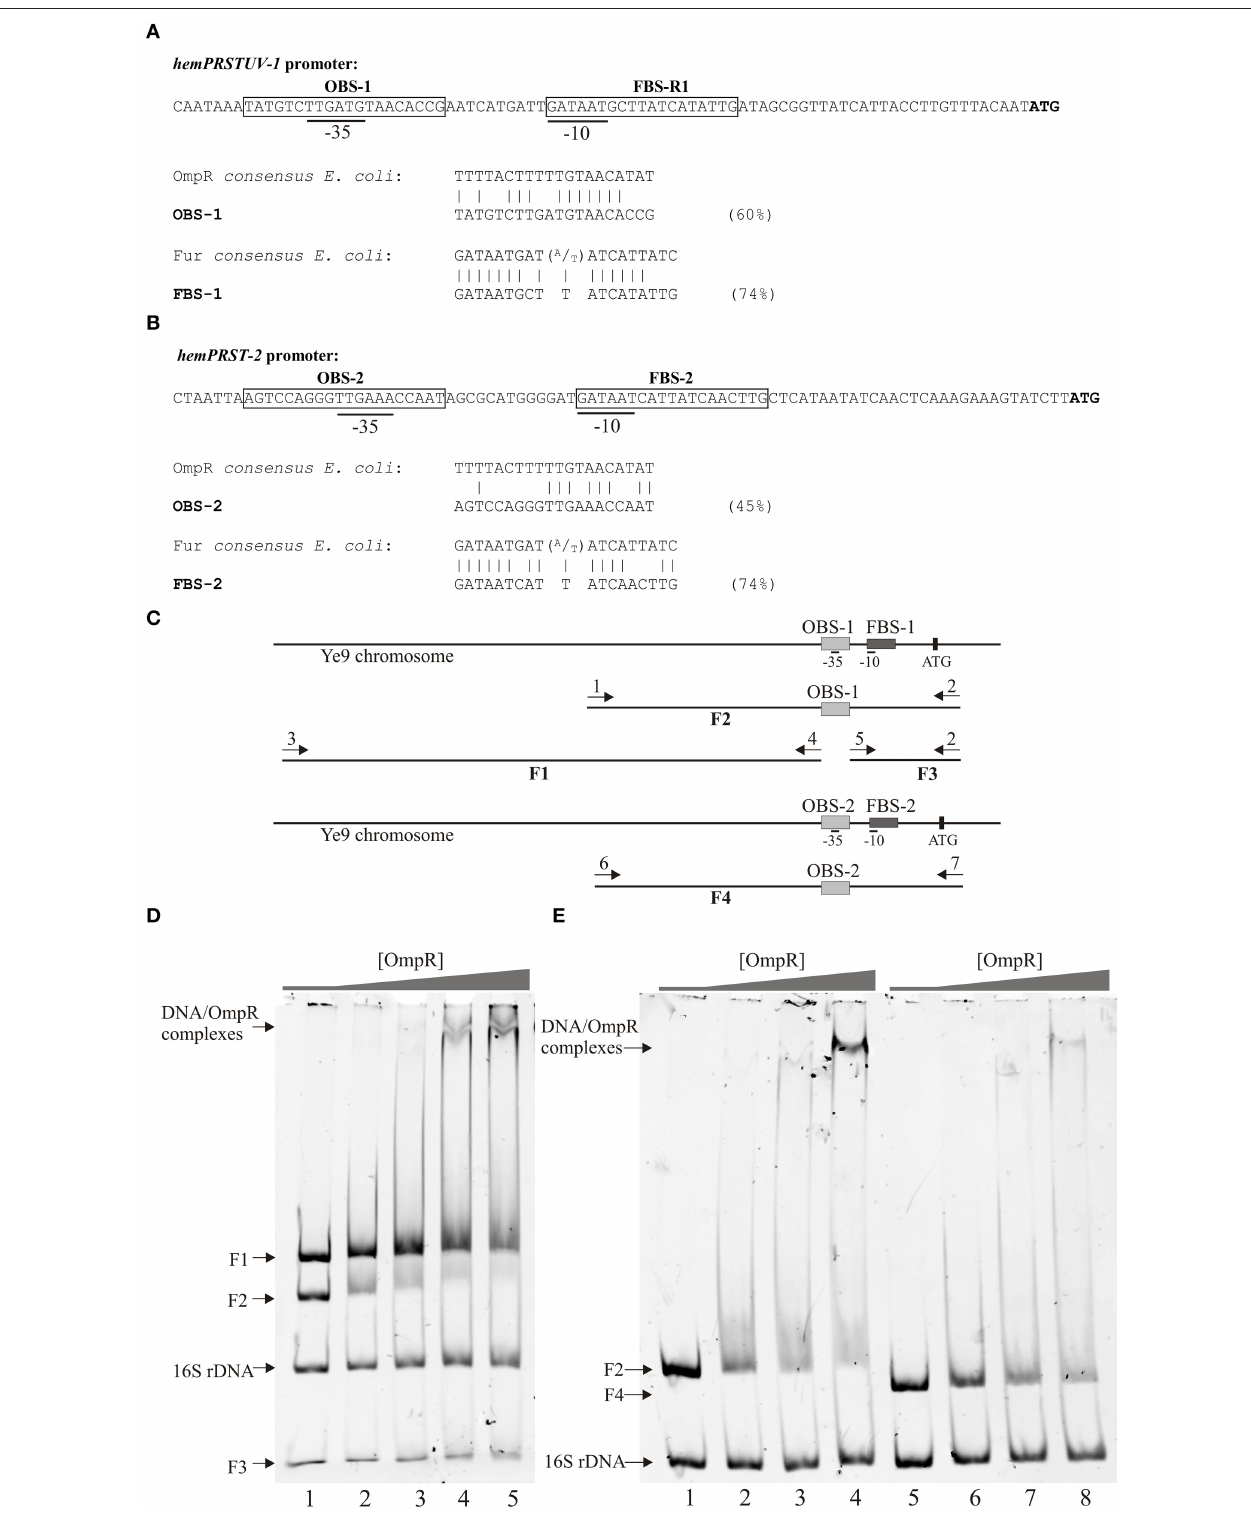
FIGURE 7 | OmpR binding to fragments of the hem -1 and hem -2 promoter regions. (A,B) OmpR- and Fur-binding sites identified in promoter regions of the two heme uptake loci. The − 35 and − 10 promoter elements are underlined and putative regulator-binding sites are boxed. The ATG start codon of the first ORF of each operon is shown in bold. FBS, Fur-binding site; OBS, OmpR-binding site. (C) Schematic representation of fragments used in EMSA experiments presented in (D) and (E) . The